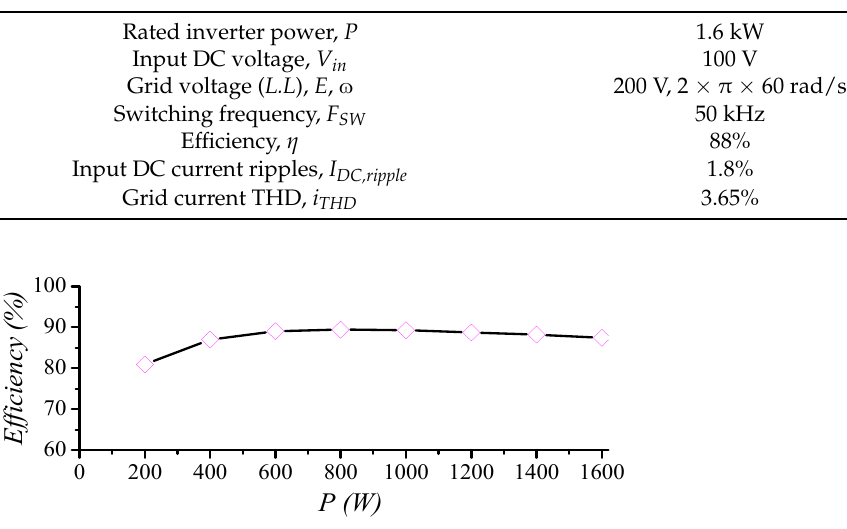
Figure 10. Grid current FFT harmonic spectrum with SOHC compensation at 1.6 kW. Table 4. IFBI experimental findings analysis.